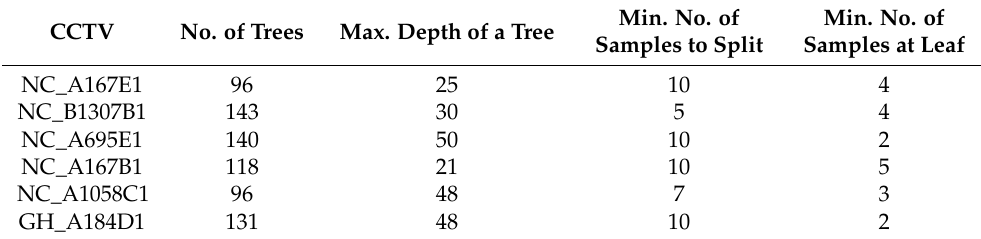
Table 3. RF tuned parameters per CCTV after grid search.